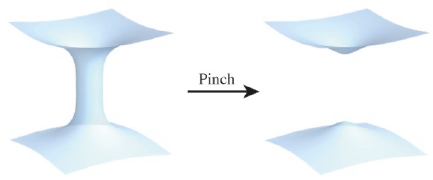
Figure 11 . A schematic picture for pinching o(cid:11) a long